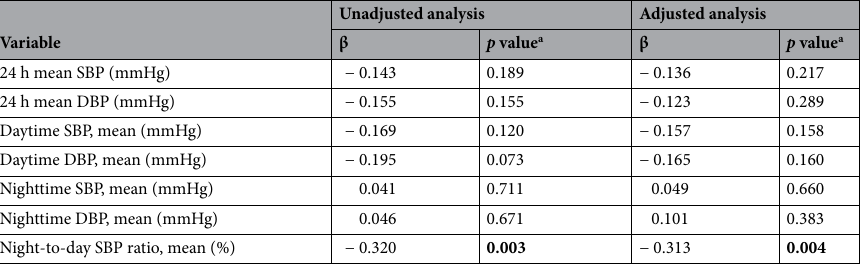
Table 4. Univariable and multivariable linear regression analyses of the association between degree of macular ischemia and blood pressure in dipper and non-dipper group. Adjusted for variables in basic and clinical parameters associated with blood pressure (age, sex, body mass index, current smoking status, and alcohol drinking status). Night to day systolic blood pressure ratio (%) = (Daytime sysBP − Nighttime sysBP)/Daytime sysBP × 100. Statistically significant values are in boldface. SBP systolic blood pressure, DBP diastolic blood pressure. a Based on linear regression analysis.